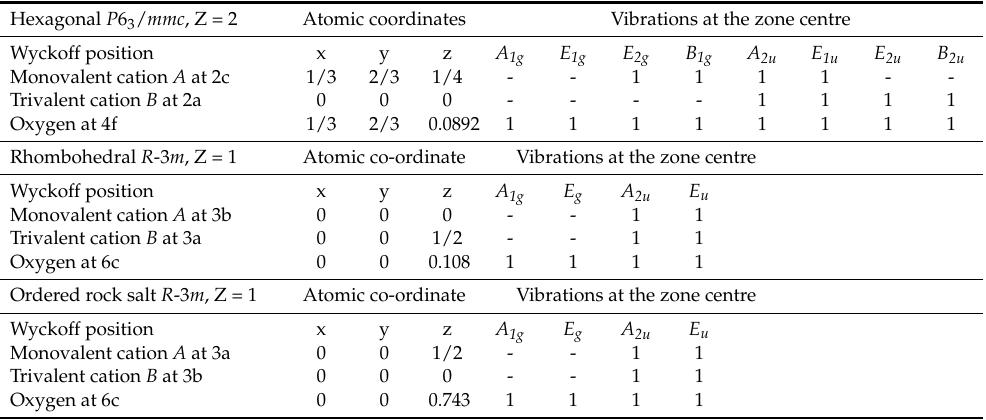
Figure 2. Eigen vectors for E g and A 1 g modes of vibration in AB O 2 delafossite compounds. Table1. Structural and vibrational details of AB O 2 type compounds.